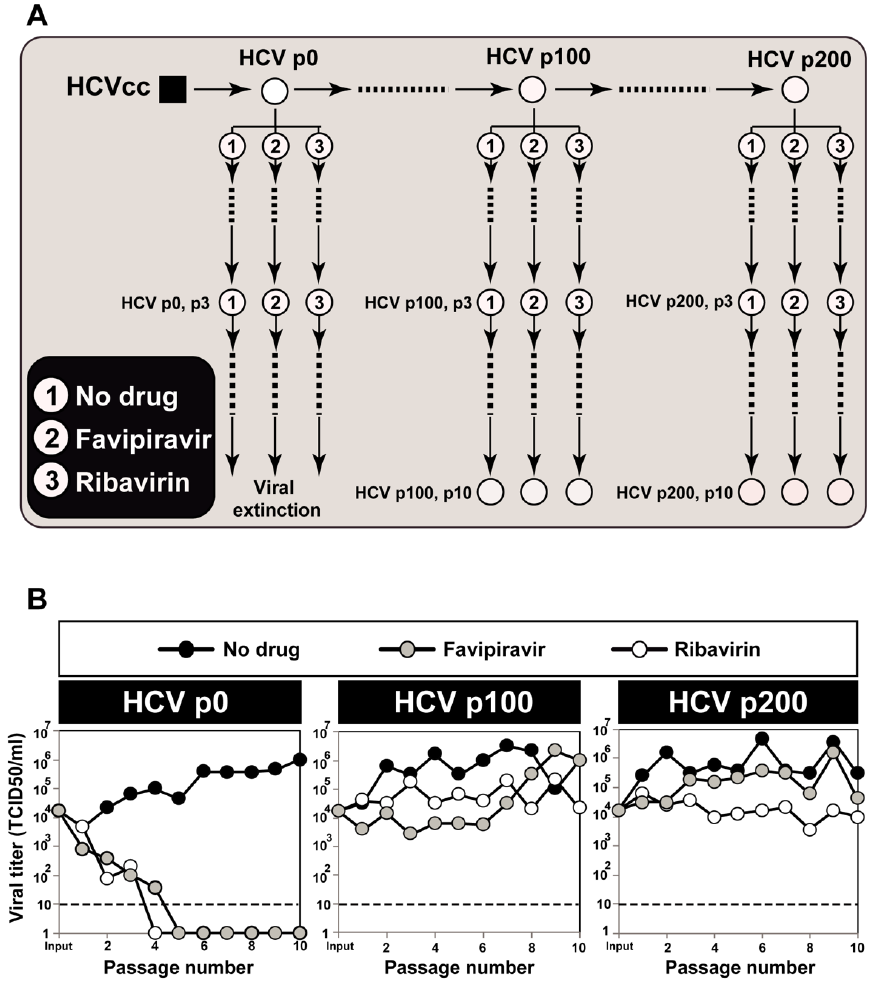
Figure 1. Passage of hepatitis C virus in the absence or presence of favipiravir or ribavirin. ( A ) scheme of the serial passages starting from populations HCV p0, HCV p100, and HCV p200. The origin of each virus is described in the text. Numbers inside circles identify the drug present